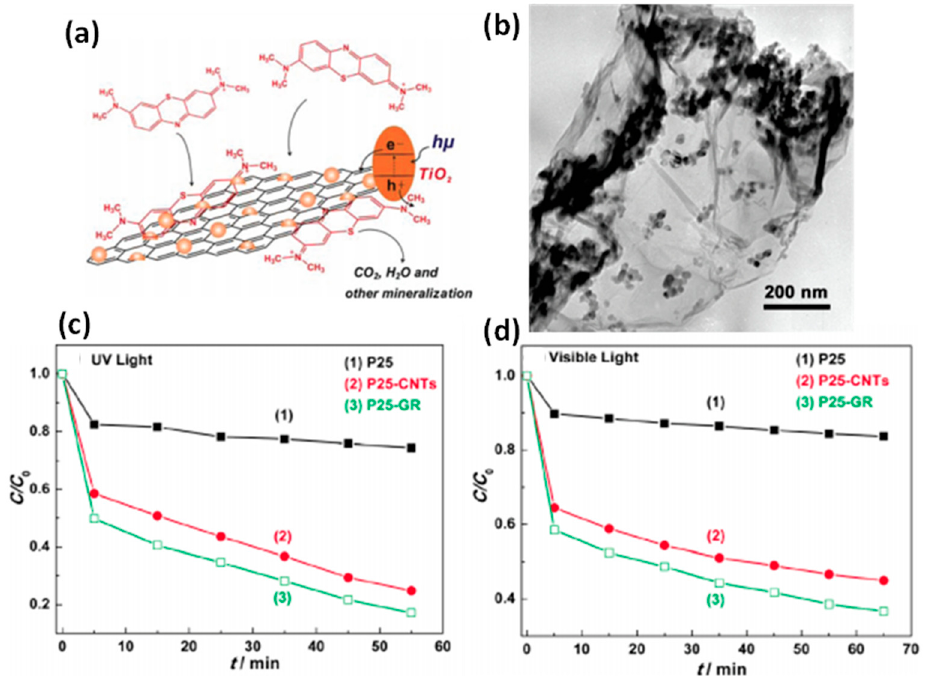
Figure 6. ( a ) Schematic of P25-GR and probable process of photodriven degradation of the dye (MB) over P-25-GR with TEM micrograph ( b ) of the composite. Comparison of photocatalytic activity in the degradation of MB under ( c ) UV light ( λ = 365 nm) and ( d ) visible light ( λ = 400 nm). Adapted with permission form Ref. [203]. Copyright 2010, American Chemical Society.